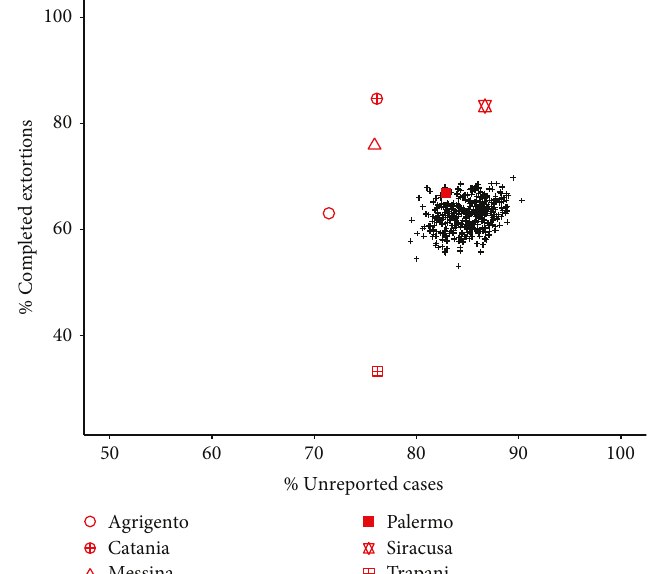
Figure 2: Comparison between empirical data of di ff erent cities in Sicily and simulated data. Simulated data shown in black while survey data shown in